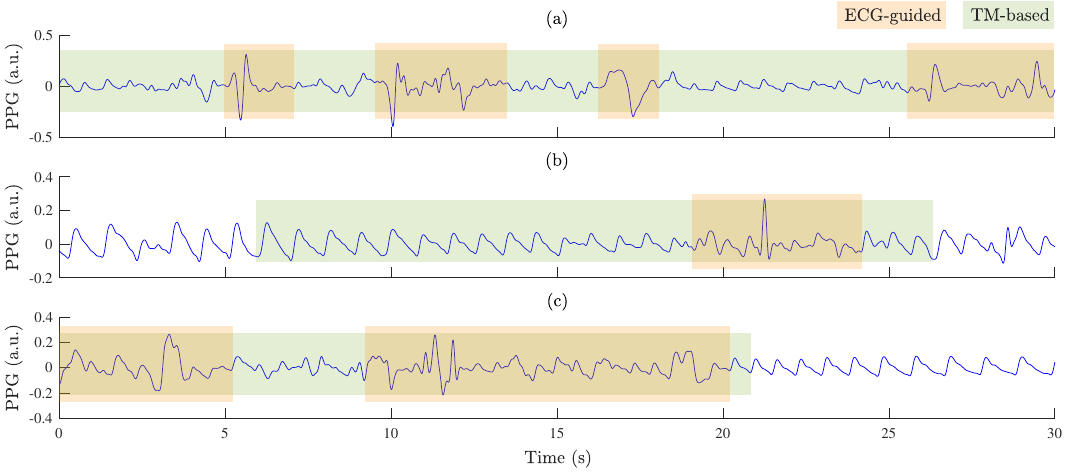
Figure 7. Examples of PPG signals with labeled poor-quality segments obtained by ECG-guided and TM-based algorithms: ( a ) wake, ( b ) oxygen desaturation, and ( c )